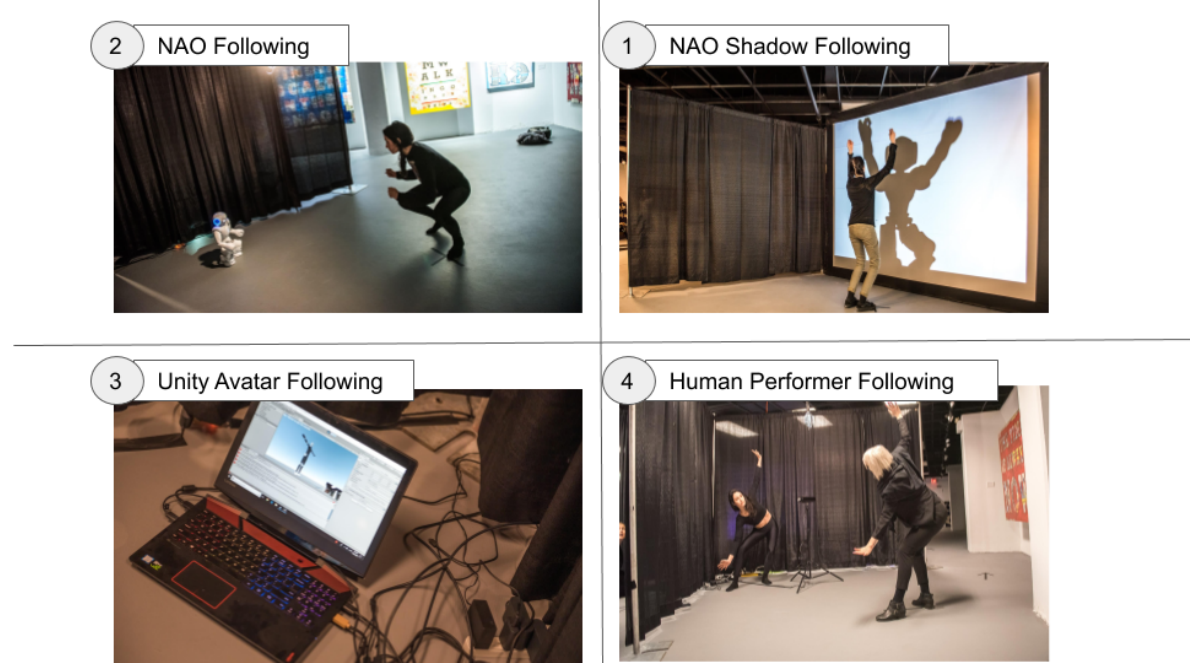
Figure 3: Images from the interactive installation at Mindset Brain Gym in Toronto, Canada. The participant began by following the large shadow of a NAO robot in the first node, then a real NAO robot in the second node, then an avatar of a human as translated by the Unity software in the third, and finally a human performer in the final fourth node. A schematic of the four stations at the final Performance 5 event is shown in Figure